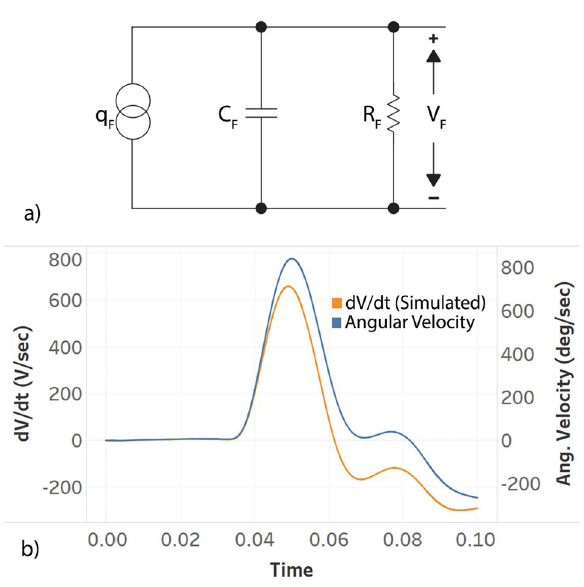
Figure 5. ( a ) Equivalent circuit model of the FENG. ( b ) Angular velocity and simulated first derivative of the FENG’s voltage plotted on a dual